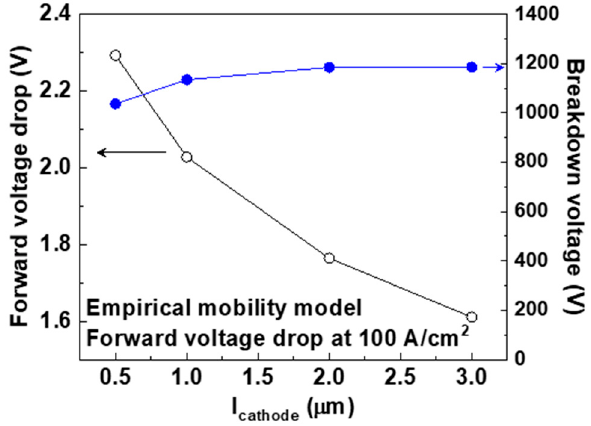
Figure 9. Simulated forward voltage drop at 100 A/cm 2 ( V f ) and breakdown voltage of the p-type diamond pseudo-vertical Schottky barrier diodes (SBDs) with values of t drift of 3.0, 4.0, 4.6, 5.0, and 6.0 μ m. The empirical mobility model used for the forward current–voltage (I–V) characteristics at 300 K.